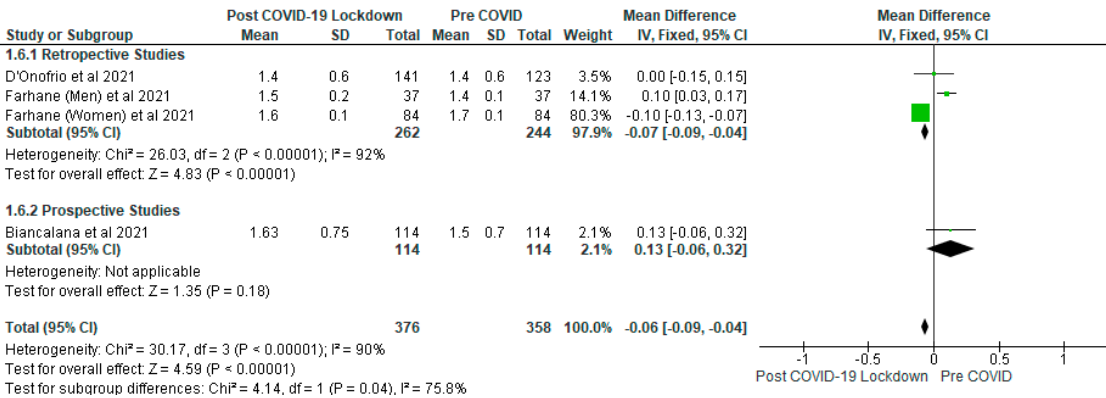
Figure 7. The effect of COVID-19 lockdown on Triglyceride (mmol/L). For LDL cholesterol (mmol/L), the mean difference was − 0.11 (95% CI: − 0.13, − 0.08) and included four studies with 734 participants (post-COVID-19 lockdown gp, n = 376; pre-COVID, n = 358) (Figure 8). The subgroup analysis for triglyceride and LDL cholesterol showed significantly ( p < 0.05) lower lev- els of these metabolites in the post-COVID-19 lockdown gp compared with pre-COVID gp in the retrospective studies while the differences were not sig- nificant ( p > 0.05) in the prospective studies (Figures 7 and 8).